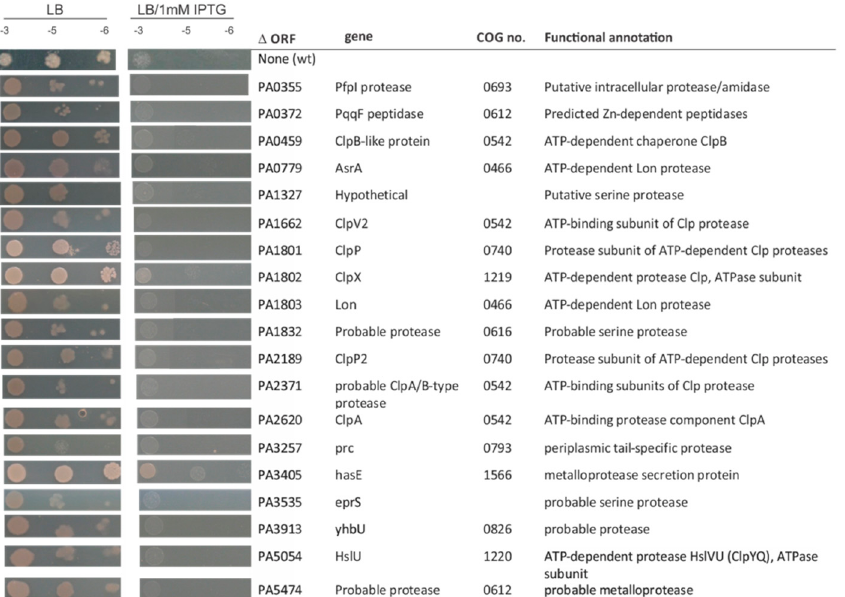
RNAP purified using the RpoA-Strep tag. Western blot using antibody specific for the intact α RNAP